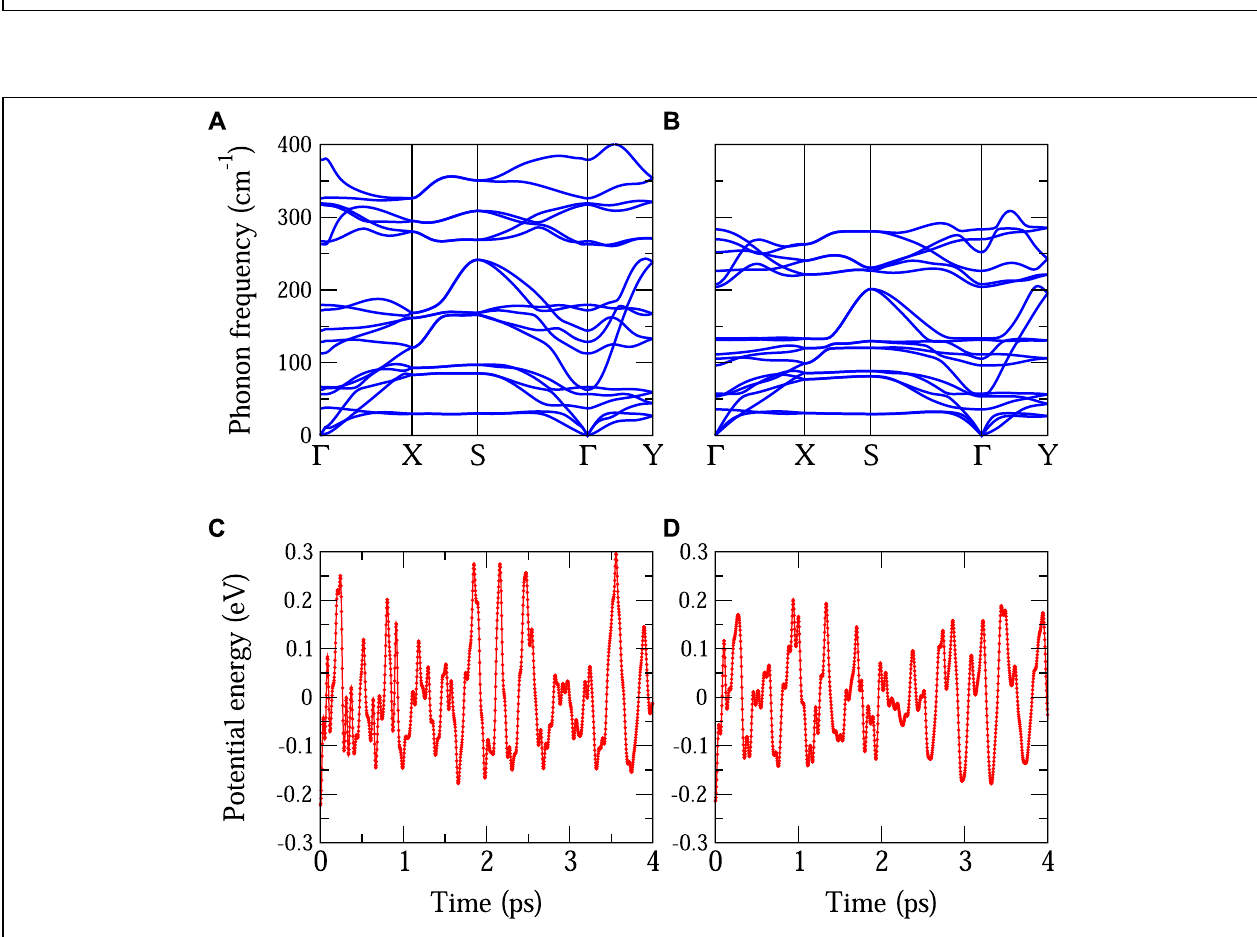
FIGURE 2 | (A , B) The phonon spectra of strain-free single-layer TiPI and TiAsI. The absence of imaginary phonons indicates the dynamical stability of both TiPI and TiAsI. (C , D) The MD simulations of TiPI and TiAsI at 300 K supporting the thermal stability of both TiPI and TiAsI. The average potential energy is chosen to be zero.